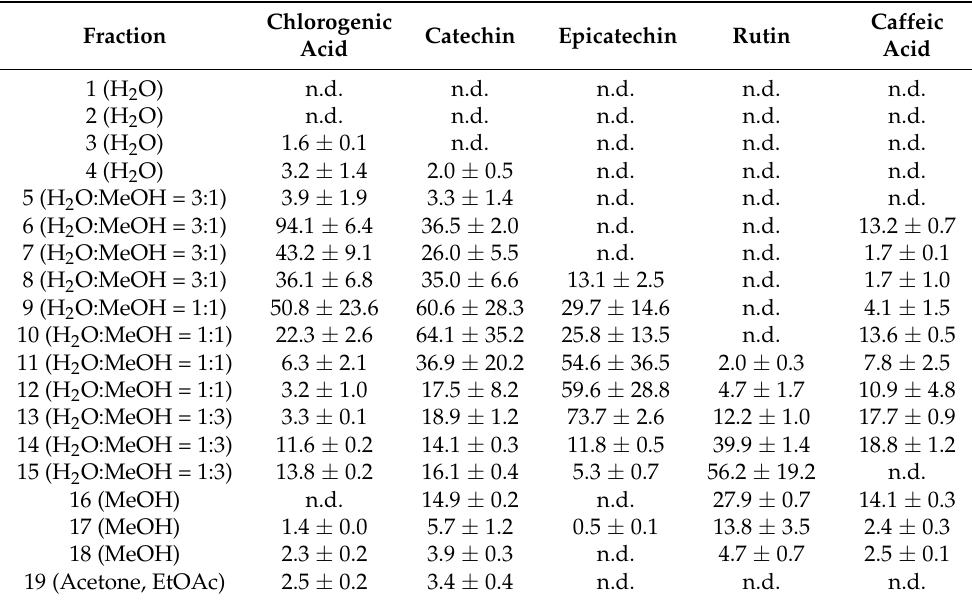
Table 4. Content of major polyphenols in fractions from water extracts of V. virgatum stems (mg/g (dry weight of fraction)).